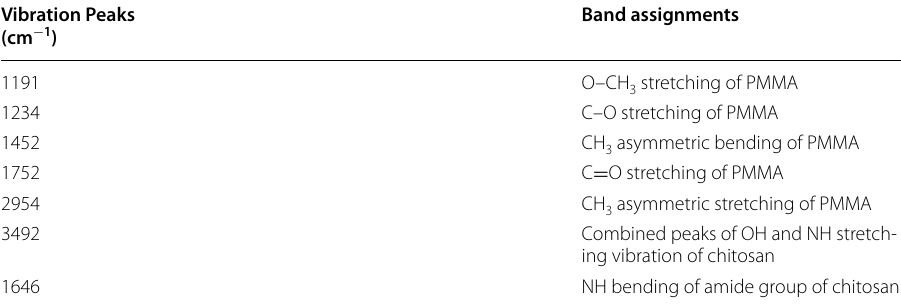
Table 2 Vibrational modes and band assignments for the polymer electrolytes (PMMA-LiTf-